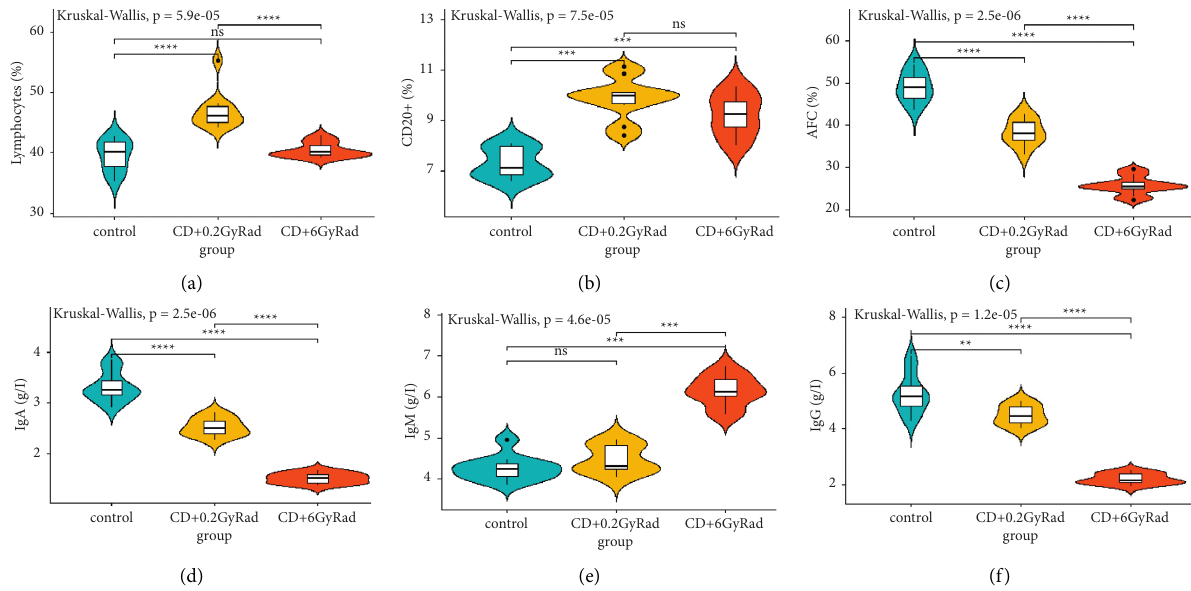
Figure 2: B-cell immune response to combined effect of coal dust and radiation: (a) lymphocytes; (b) CD20+; (c) AFC; (d) IgA; (e) IgM; (f)